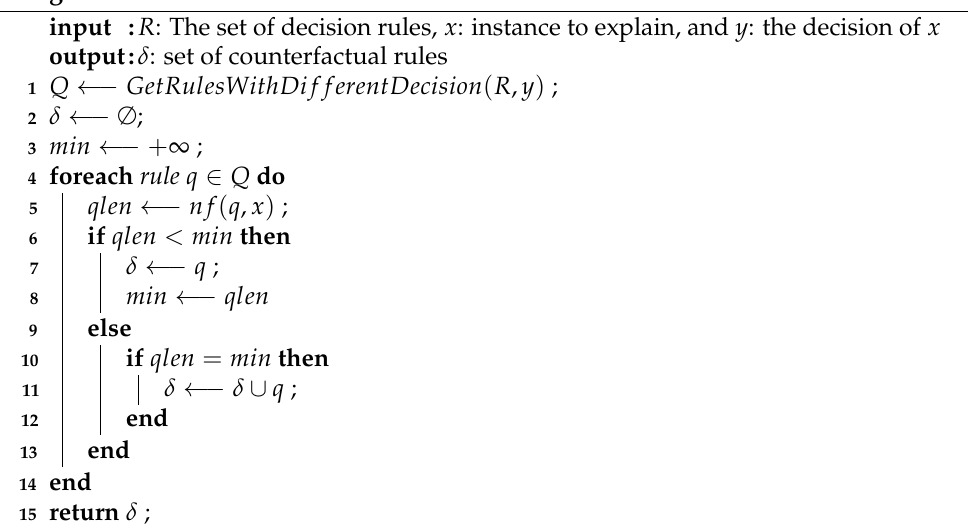
Algorithm 3: Extraction of counterfactual rules